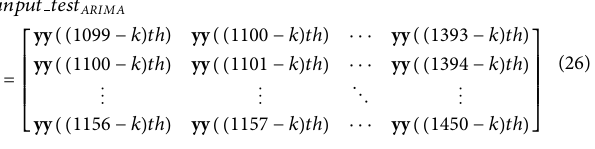
Frontiers in Energy Research |